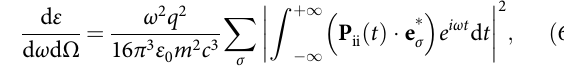
perturbation theory in the weak emitted fi eld leads to the spectrum of emitted energy per unit solid angle d Ω per unit frequency d ω :